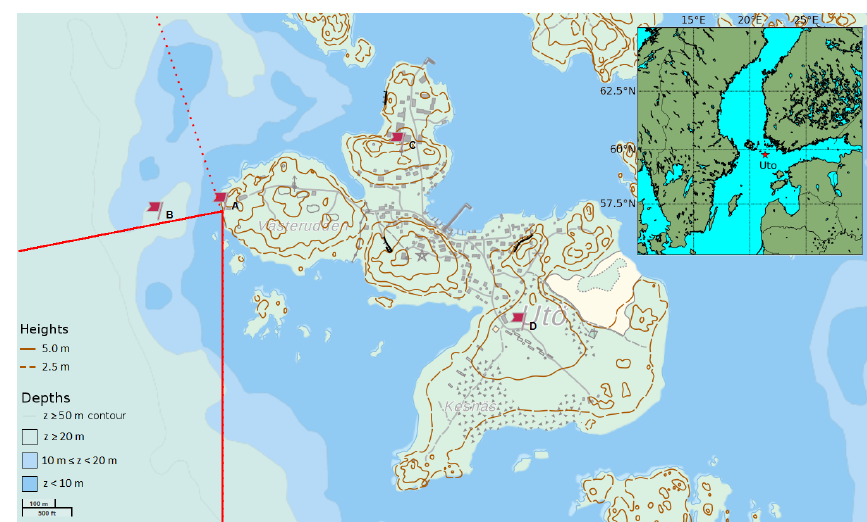
Figure 1. Location of the island of Utö in the Archipelago Sea. The research installations on the island consist of the Utö Atmospheric and Marine Research Station and its flux tower (A), the inlet of the seawater sampling system (B), the Atmospheric ICOS station (C), and a weather and air quality station (D). The red solid lines indicate the wind sector used for sea–air flux measurements (180–260 ◦ ) used in this paper, and the dashed line indicates the fetch-limited sea sector excluded from the current analysis.